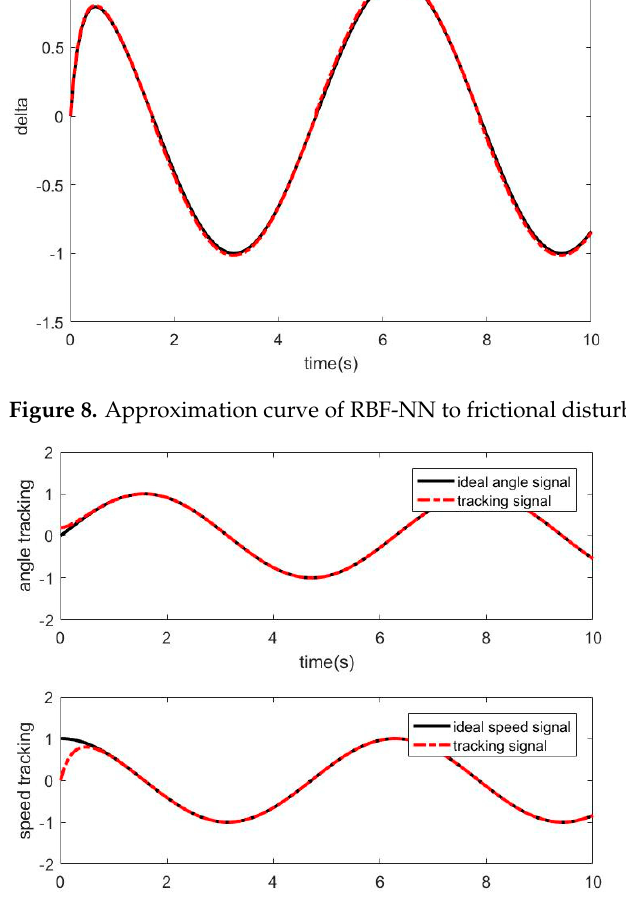
Figure 9. Tracking curve of RBF −− NN ASMC with friction disturbance.